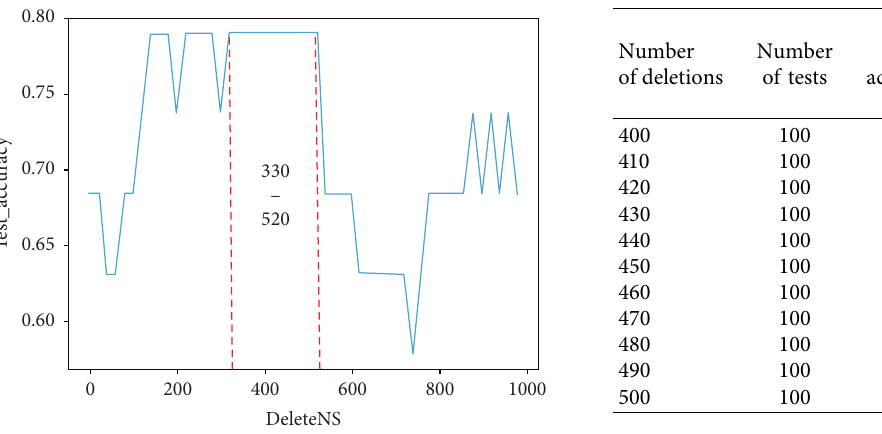
Figure 2: Curve 2 of deleteNS and classification accuracy.